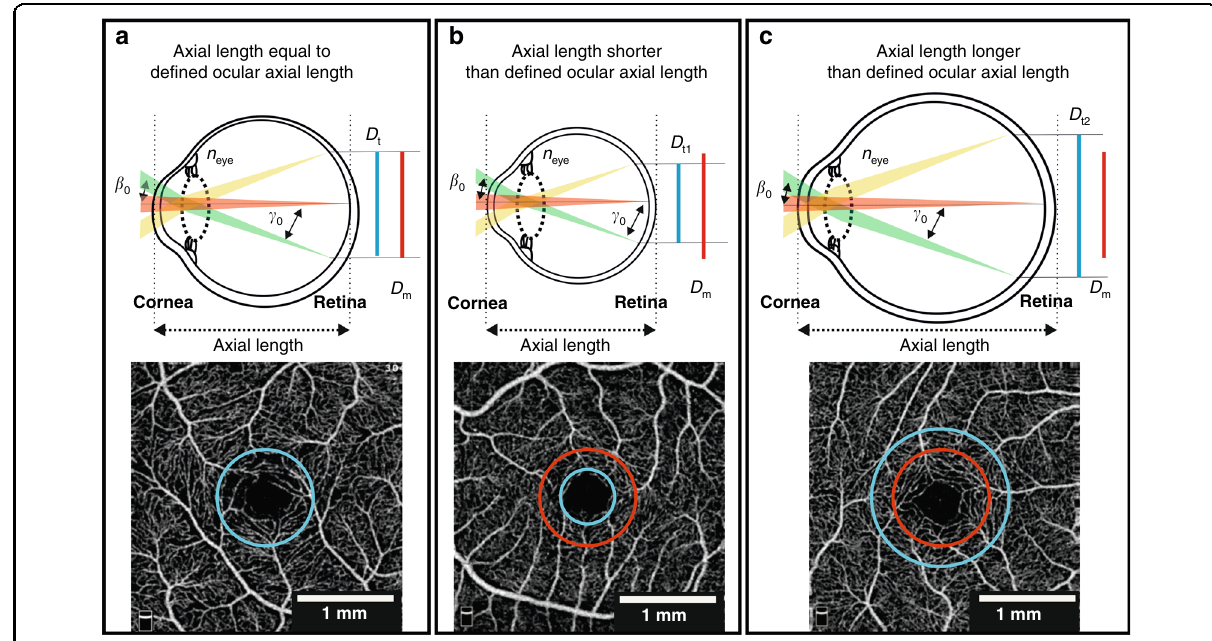
Fig. 7 Effect of varying axial length on OCTA scan dimensions. The incident beam is shown for three scan paths (green, red, and yellow; β 0 is the incident angle at the cornea and γ 0 is the angle subtended on the retina); green and yellow paths represent the maximum deviations, and the red path is on axis. Refraction from the scan lens (not shown), cornea, and lens focuses each light path on the retina. a Axial length equal to the de fi ned ocular axial length of OCTA instrument so the linear size of the measured retinal diameter ( D m ) corresponds to the true retinal diameter ( D t ). b Axial length shorter than de fi ned ocular axial length results in D t 1 < D m . c Axial length longer than de fi ned ocular axial length results in D t2 > D m . Below each schematic diagram, a visual representation demonstrates how the OCTA instrument would measure a ring of 1 mm diameter (without correction for axial length variation, red circle) in each case versus the true 1 mm diameter (blue ring). Adapted with permission from